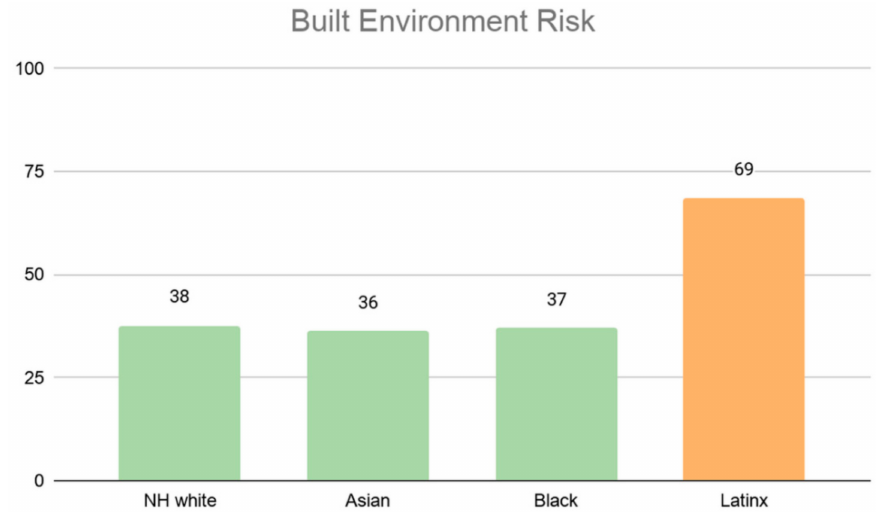
Figure 13. Average built environment risk index by Los Angeles neighborhood’s racial majority.